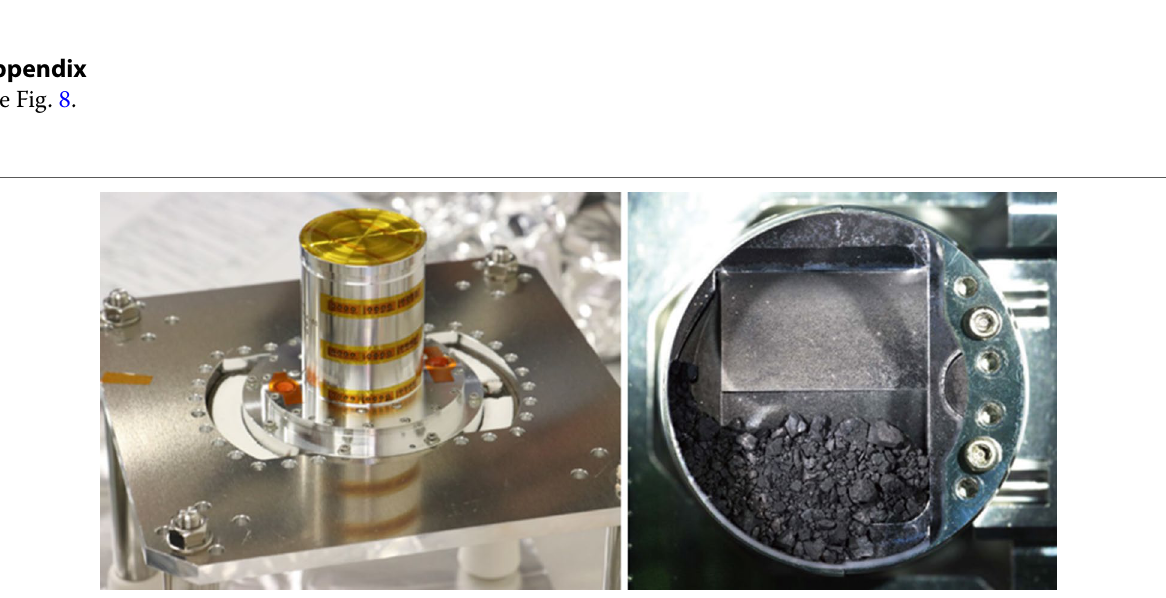
Fig. 8 a Hayabusa2 sample box from the asteroid Ryugu. b Photos taken immediately after opening the sample box. The sample catcher diameter is 48 mm (credit: JAXA). The fireball movie captures taken near Coober Pedy, Australia, are provided in the Additional file 3: Movie S2, Additional file 4: Movie S3, Additional file 5: Movie S4 (credit: